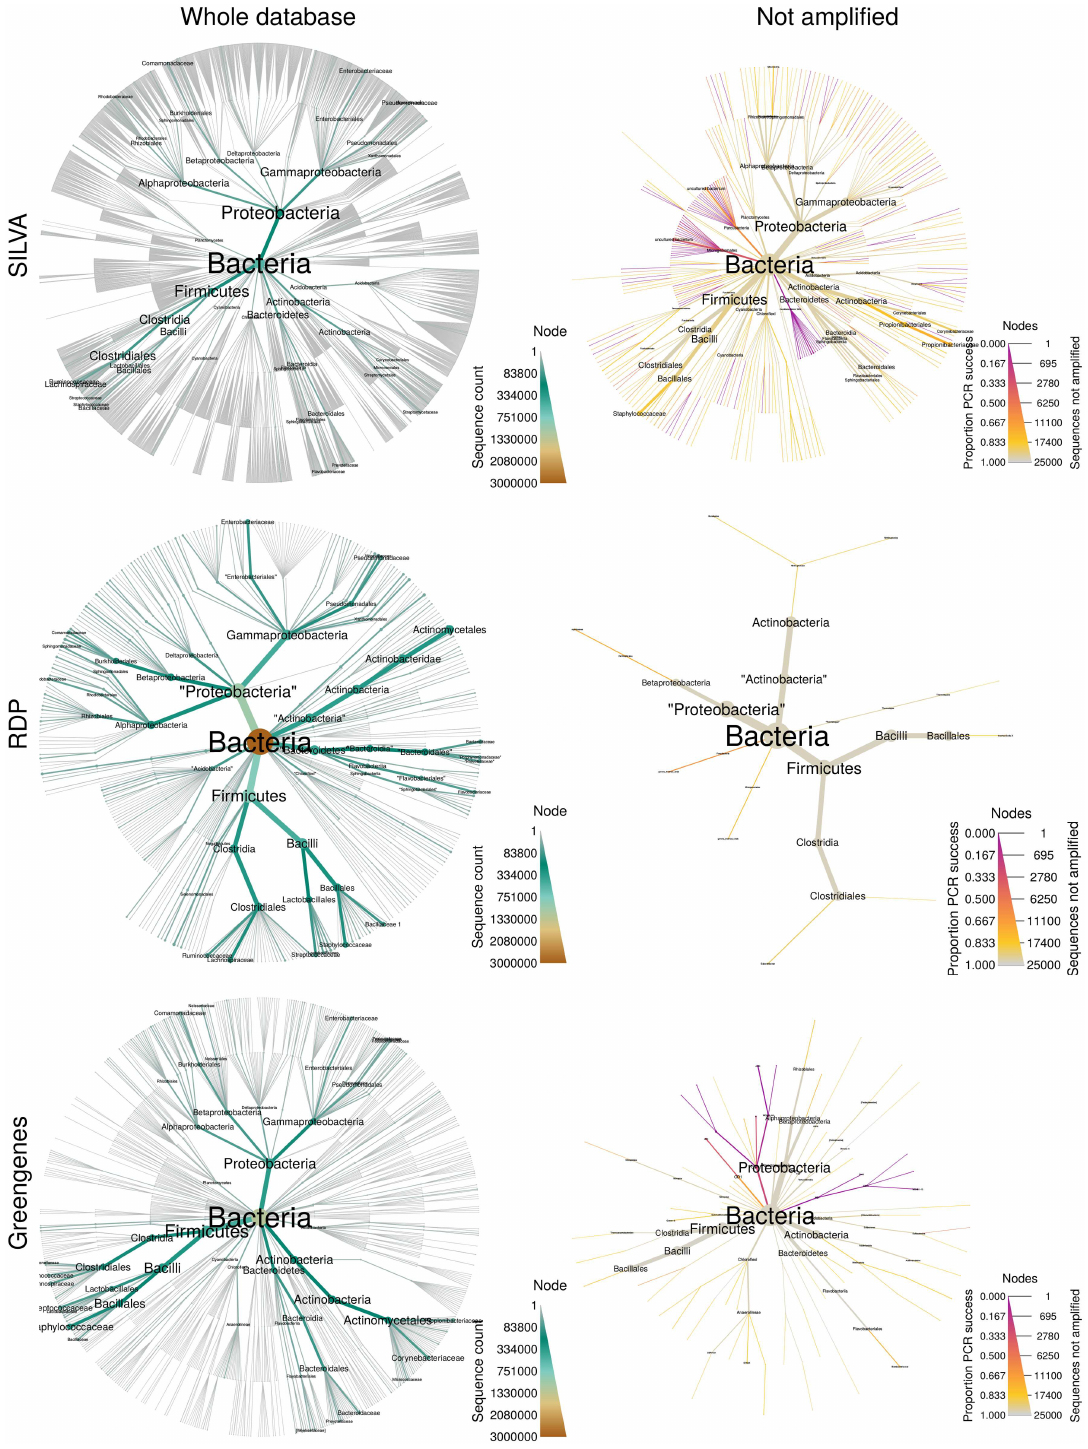
Fig 4. Flexible parsing and digital PCR allows for comparisons of primers and databases. Shown is a comparisonof digital PCR results for three 16S reference databases. The plots on the left displayabundanceof all bacterial 16S sequences. Plots on the right displayall taxa with subtaxa not entirely amplifiedby digital PCR using universal16S primers [18]. Node color and size displaythe proportionand numberof sequencesnot amplifiedrespectively.